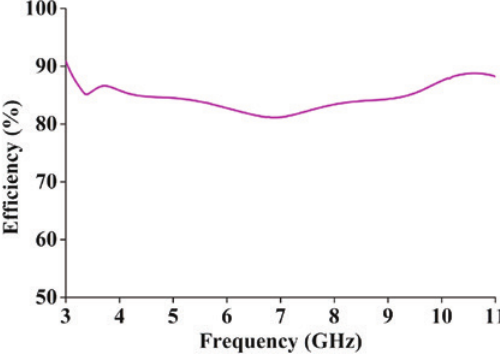
Figure 12: Efficiency of the proposed antenna.